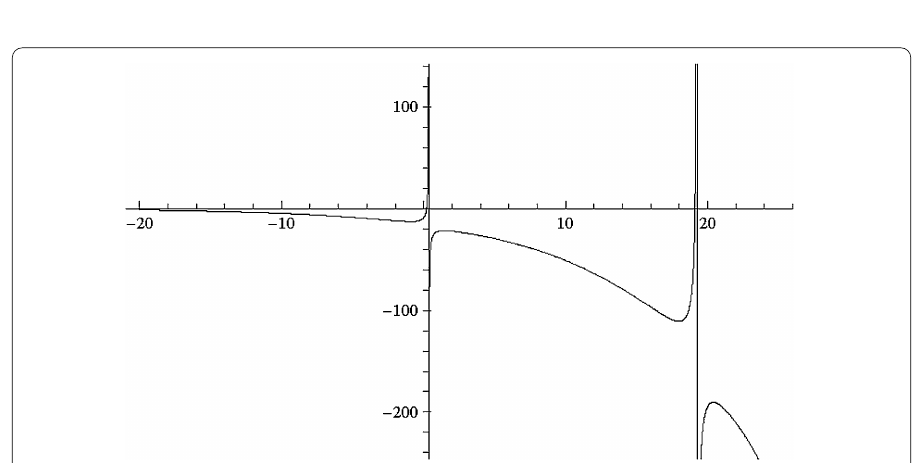
Figure 8 Graph of (cid:2) d ( ς ) for Example 3